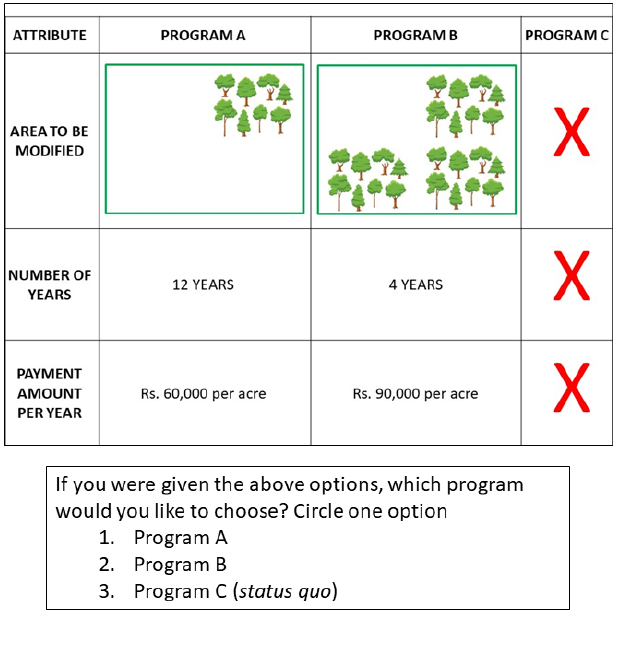
Fig. 3. An example choice experiment card used during the surveys in Pench Tiger Reserve, Madhya Pradesh. Each respondent was shown three such cards, with different program options and the option to opt out (i.e., stay at status quo). Note: Rs. – Indian Rupees ($1 USD = Rs. 70 at the time